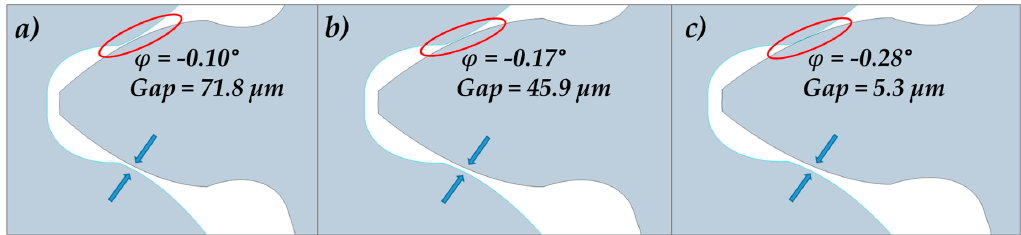
Figure 7. Three different pump configurations: ( a ) φ of − 0.10° and gap size of 71.8 μ m, ( b ) φ of − 0.17° and gap size of 45.9 μ m and ( c ) φ of − 0.28° and gap size of 5.3 μ m.